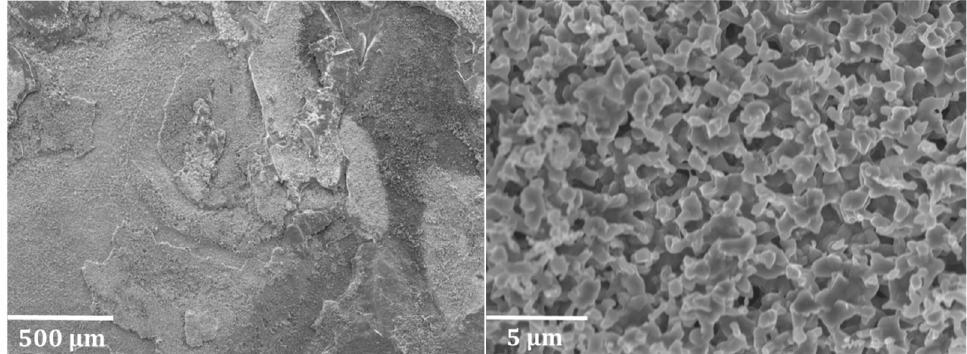
Figure 4. Decoked Ti–base alloy coupon after application of pretreatment A and eight coking/decoking cycles using pretreatment A. Accelerating voltage of 10 kV.